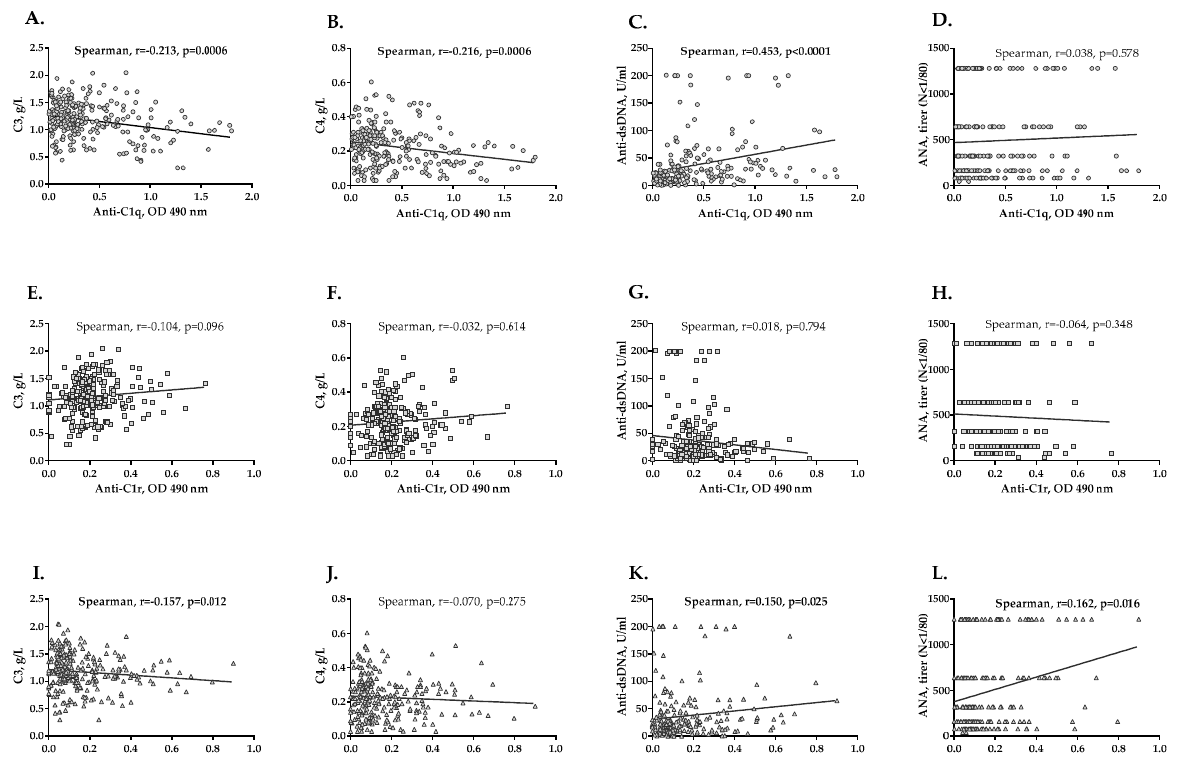
Figure 4. Correlation analysis between anti-C1q, anti − C1r and anti − C1s antibodies and markers of immunological activity in LN. Correlation between anti − C1q antibodies and levels of C3 ( A ), C4 ( B ), anti − dsDNA ( C ) and ANA titers ( D ). Correlation between anti − C1r antibodies and levels of C3 ( E ), C4 ( F ), anti − dsDNA ( G ) and ANA titers ( H ). Correlation between anti − C1s antibodies and levels of C3 ( I ), C4 ( J ), anti − dsDNA ( K ) and ANA titers ( L ).